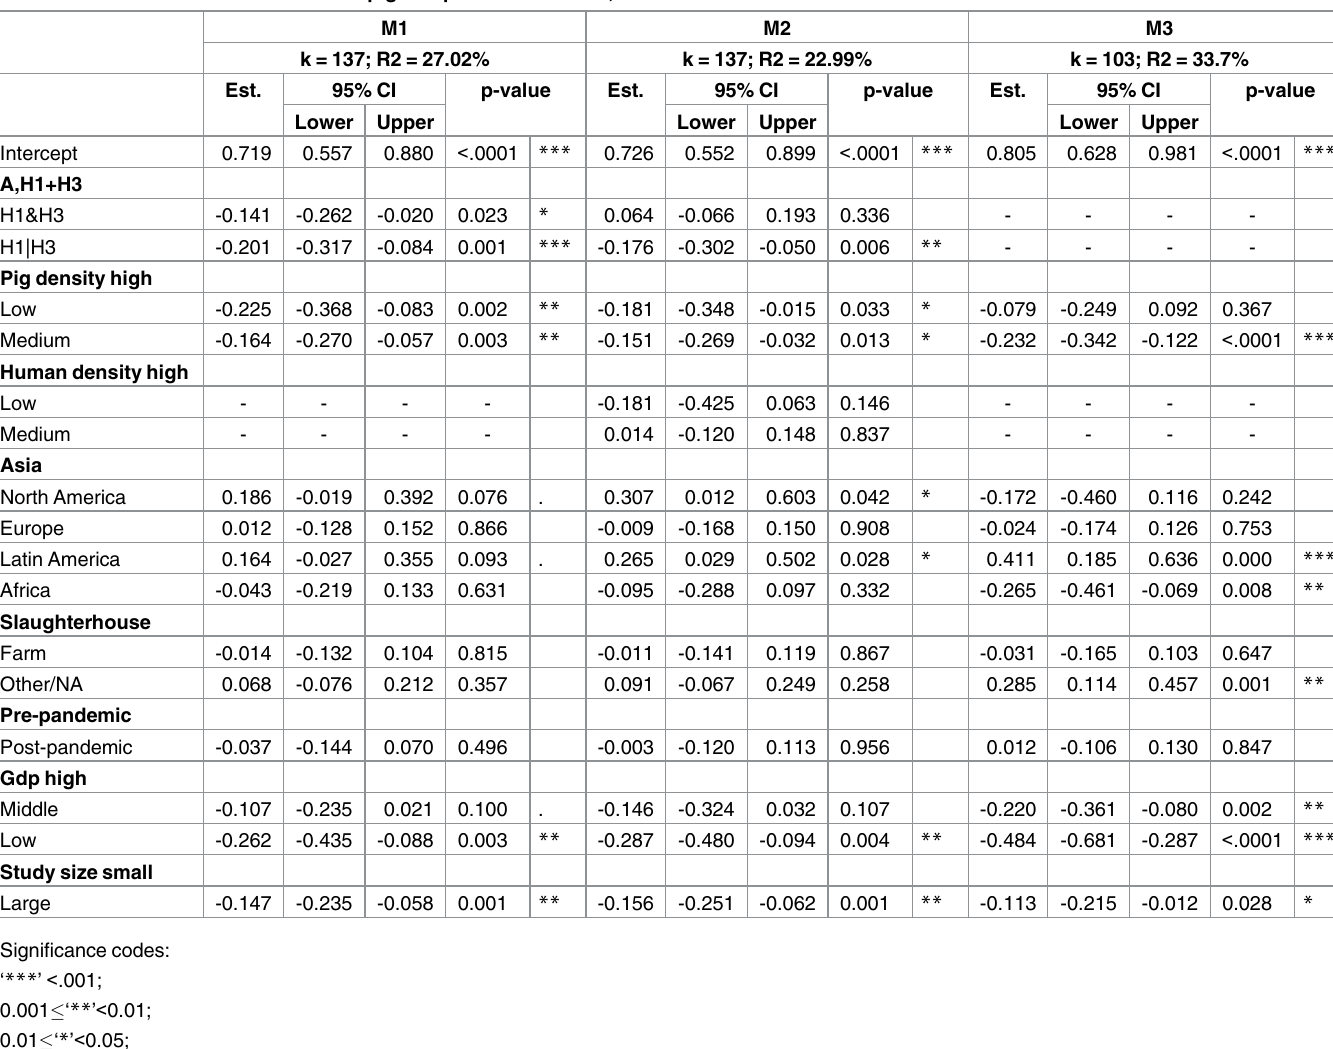
Table 2. Final mixed-effects models for pig seroprevalence for M1, M2 and